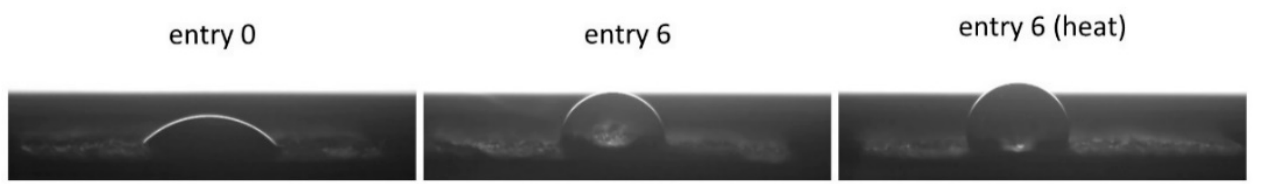
Figure 7. Water contact angles on the degreased wood (entry 0) and benzylated wood (entry 6) surfaces before and after heat treatment. Error bar shows the standard deviations based on the values of 3–5 samples.